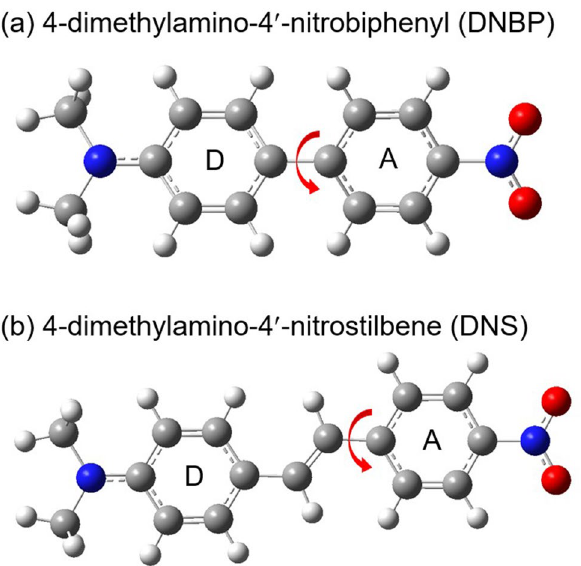
Figure 1. Molecular structures of nitroaromatic push–pull chromophores, ( a ) 4-dimethylamino-4 ′ - nitrobiphenyl (DNBP) and ( b ) 4-dimethylamino-4 ′ -nitrostilbene (DNS) optimized in the ground state by the DFT simulations at the B3LYP/6-311G(d,p) level with the polarized continuum model (PCM) for CHCl 3